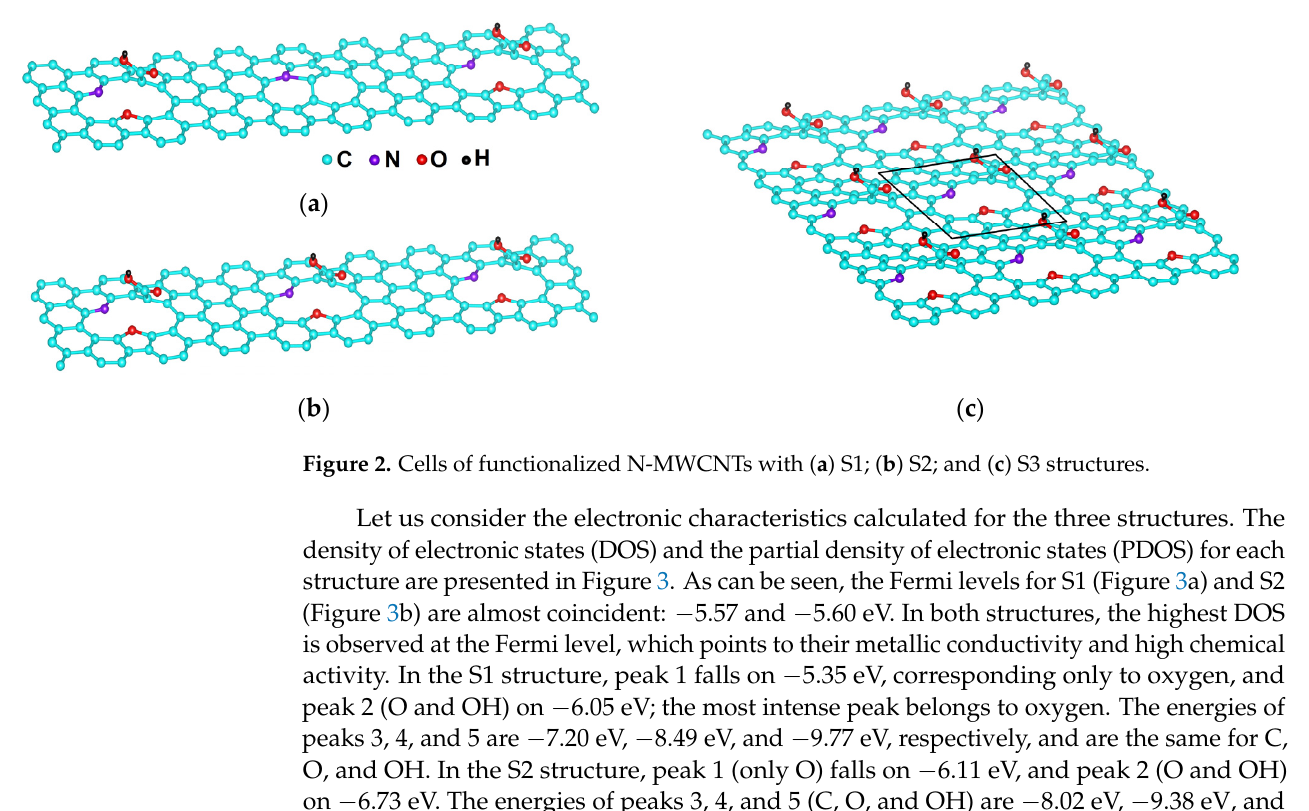
Figure 2. Cells of functionalized N-MWCNTs with ( a ) S1; ( b ) S2; and ( c ) S3 structures.